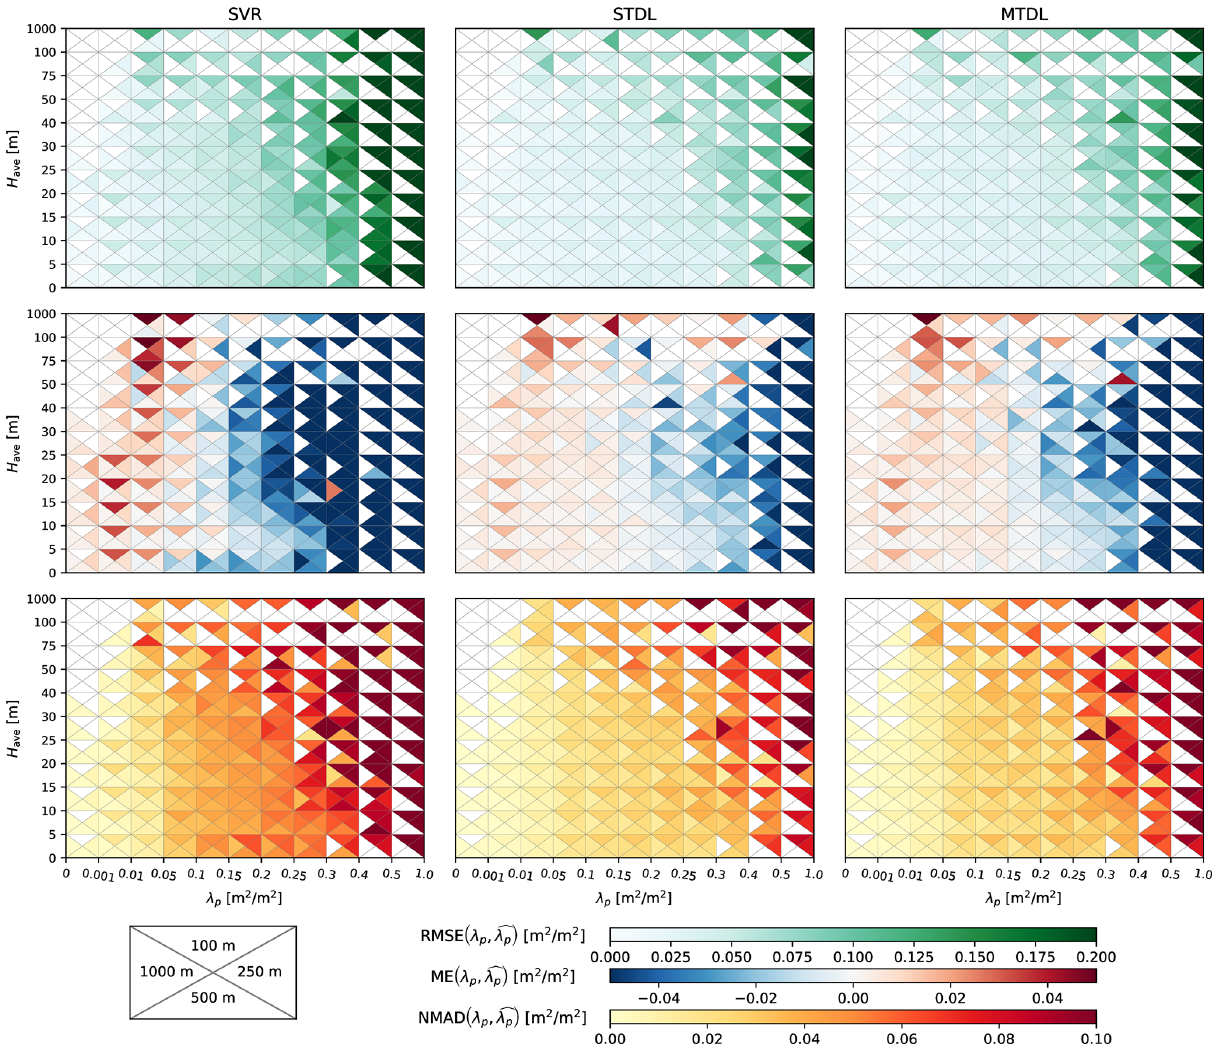
Figure 7. Same as Fig. 6, but for building footprint